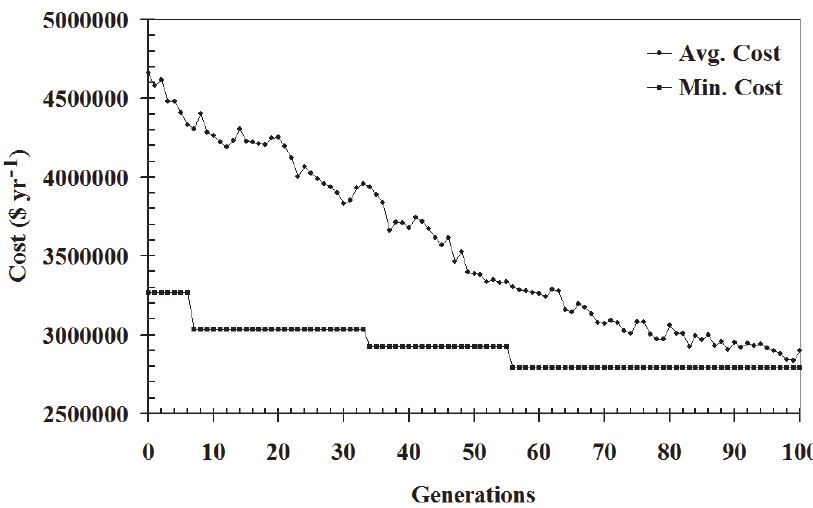
Fig. 7 – Minimum and average cost vs. generation for case study one Figure 7